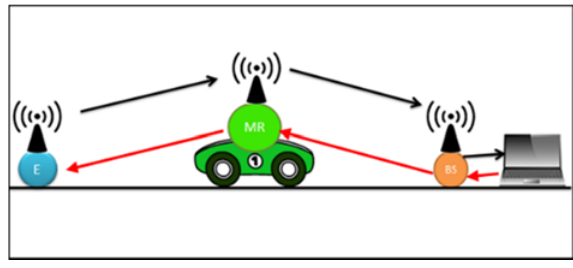
Figure 15. Mobile Router Experiment.